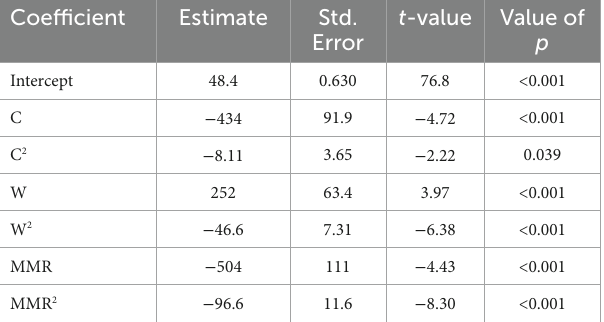
TABLE 3 Result of the multiple regression analysis with quadratic polynomials of curvature (C), MMR, and width (W) as predictors without interaction